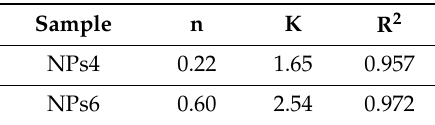
Table 2. Basic kinetic parameters of the process of Cis kinetics release from both PNVP and PCL-based NPs